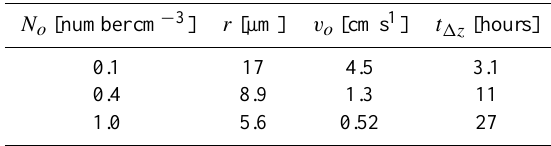
Table 2. Same as Table 1 but for a cloud thickness ( 1z ) of